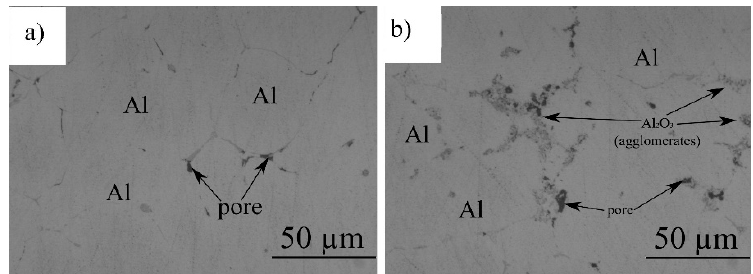
Figure 2. Optical metallography of ( a ) AA6082 and ( b ) composite AA6082-0.2 wt % Al 2 O 3 , produced by casting with ultrasonic processing.